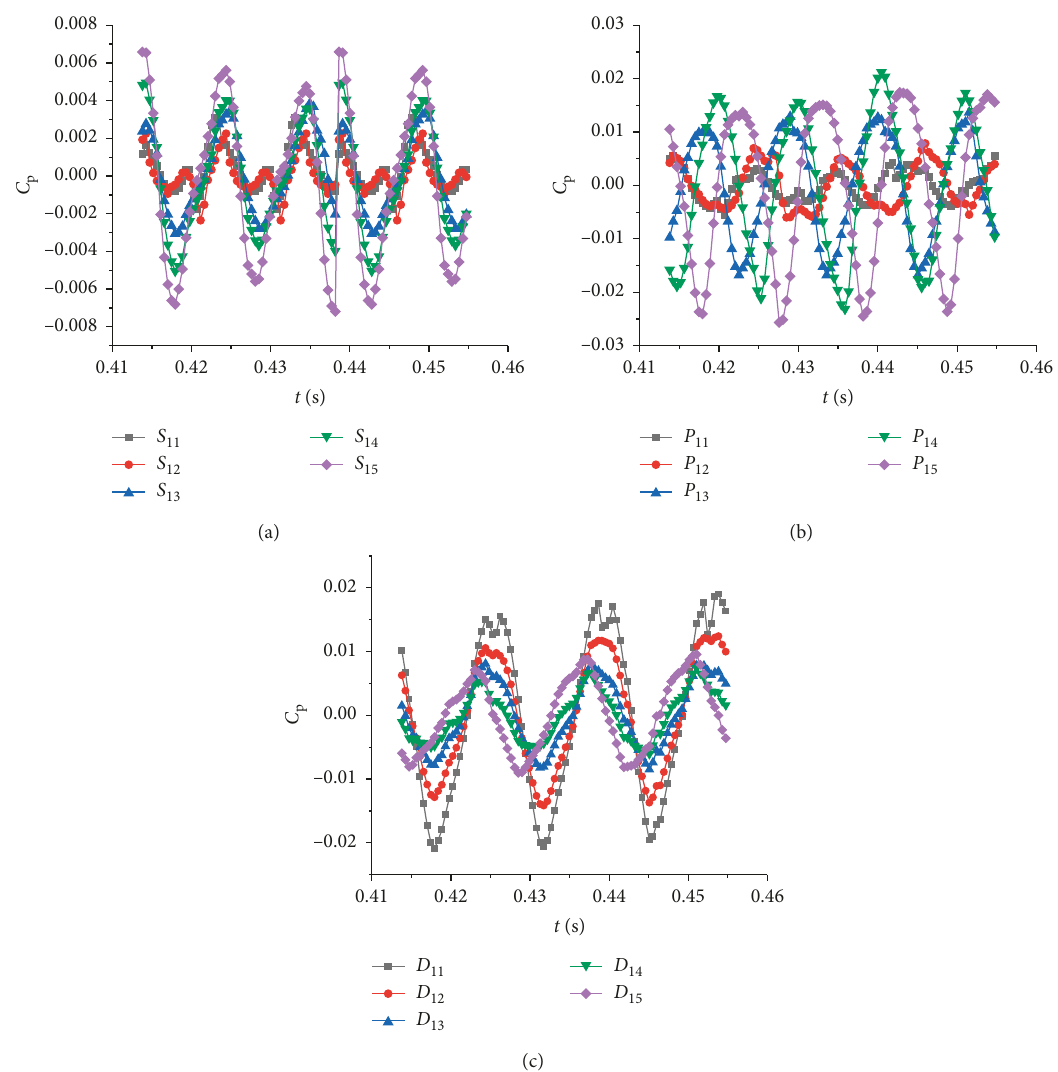
Figure 9: Pressure pulsation time-domain diagram of the first stage: (a) impeller blade suction side, (b) impeller blade pressure side, and (c)